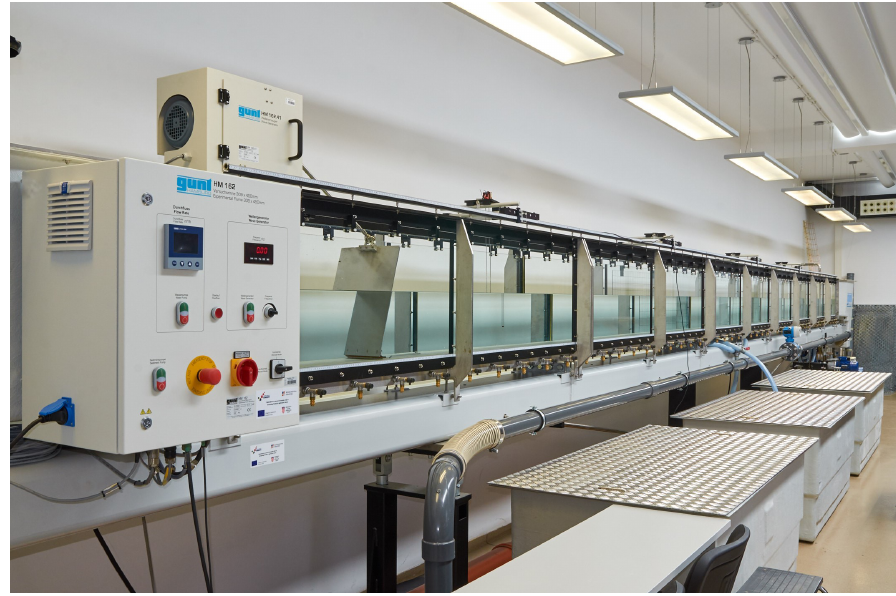
Figure 1. Experimental flume as part of the Hydrotechnical Laboratory at the University of